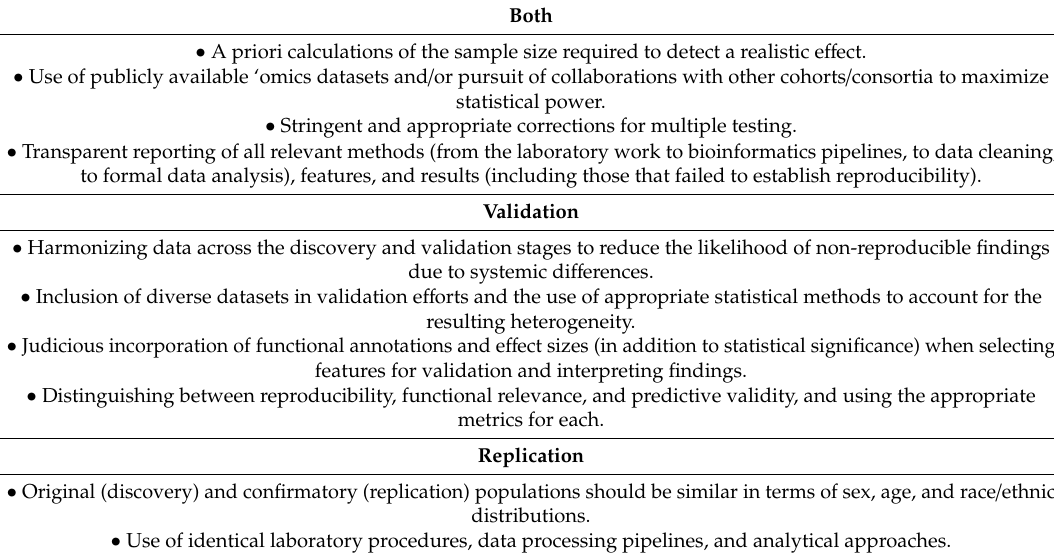
Table 1. Best practices for replication and validation of ‘omics